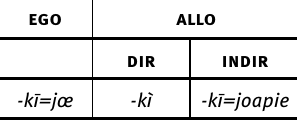
Table 2. Egophoricity and evidentiality in Shigatse Tibetan